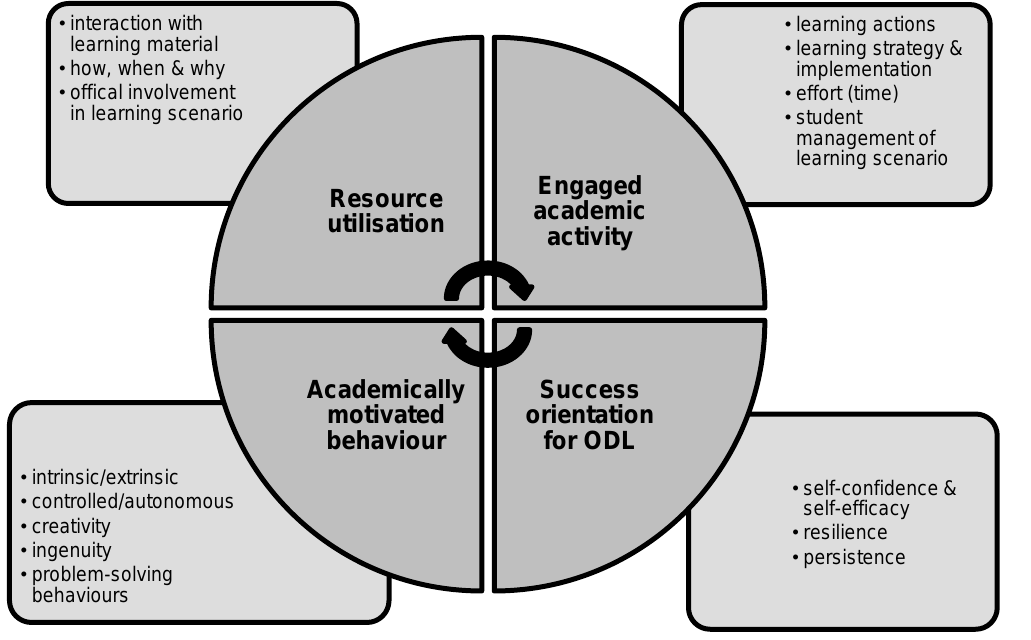
Figure 1 . Model of